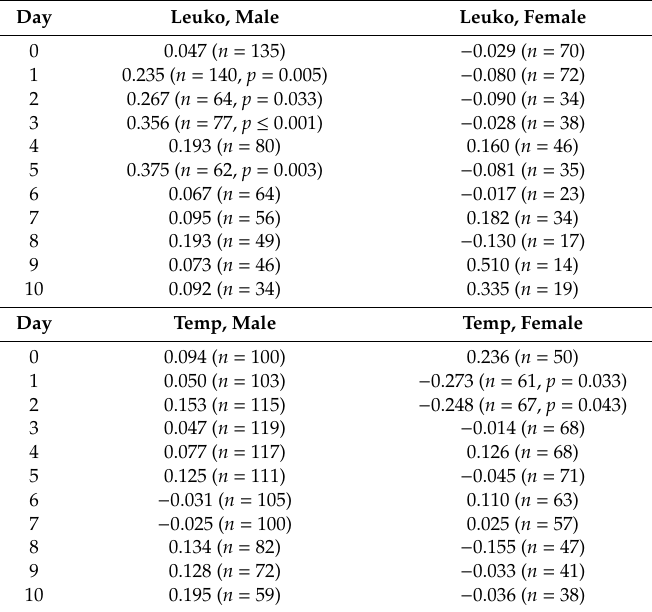
Linear regression analysis of preoperative C-reactive protein (CRP) values versus postoperative CRP, leukocyte number (leuko) and body temperature (temp). The correlation coefficients ( r ) as well as n -numbers and p -values ( ≤ 0.05) are given.